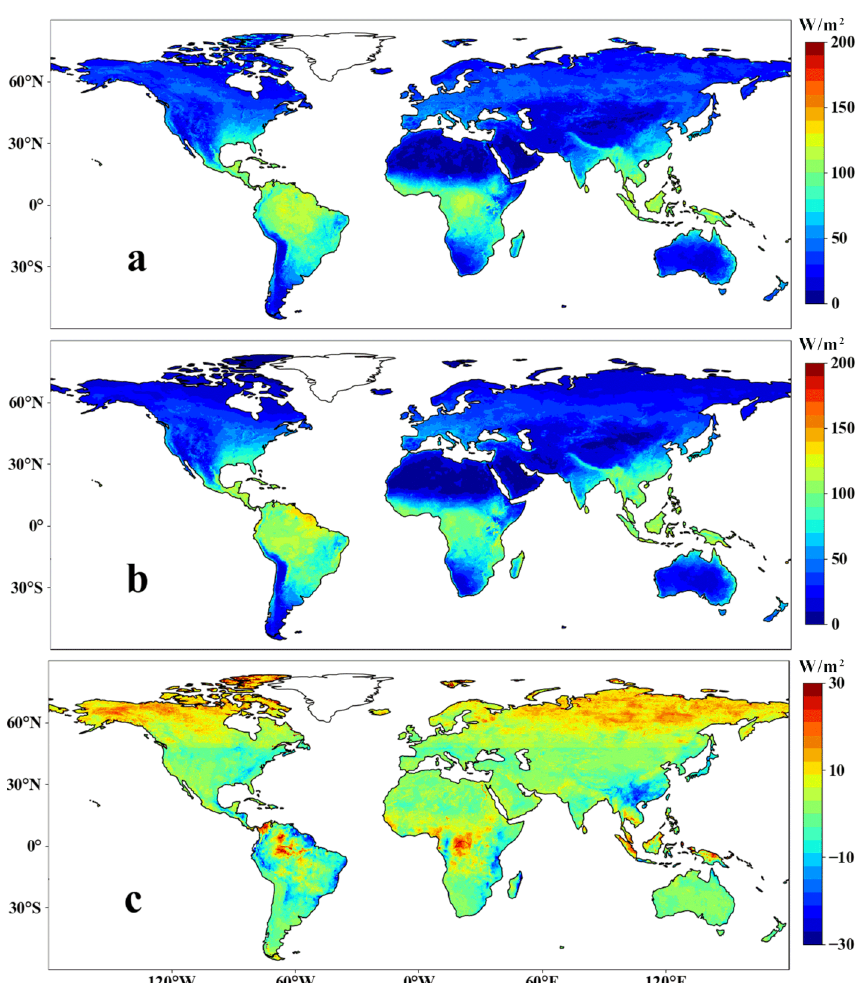
Figure 7. Spatial patterns of average annual LE (W / m 2 ) of GLASS-based LE ( a ) and MERRA-2-based LE ( b ) in the period from 2007 to 2017 and their difference (GLASS- MERRA-2, ( c )).